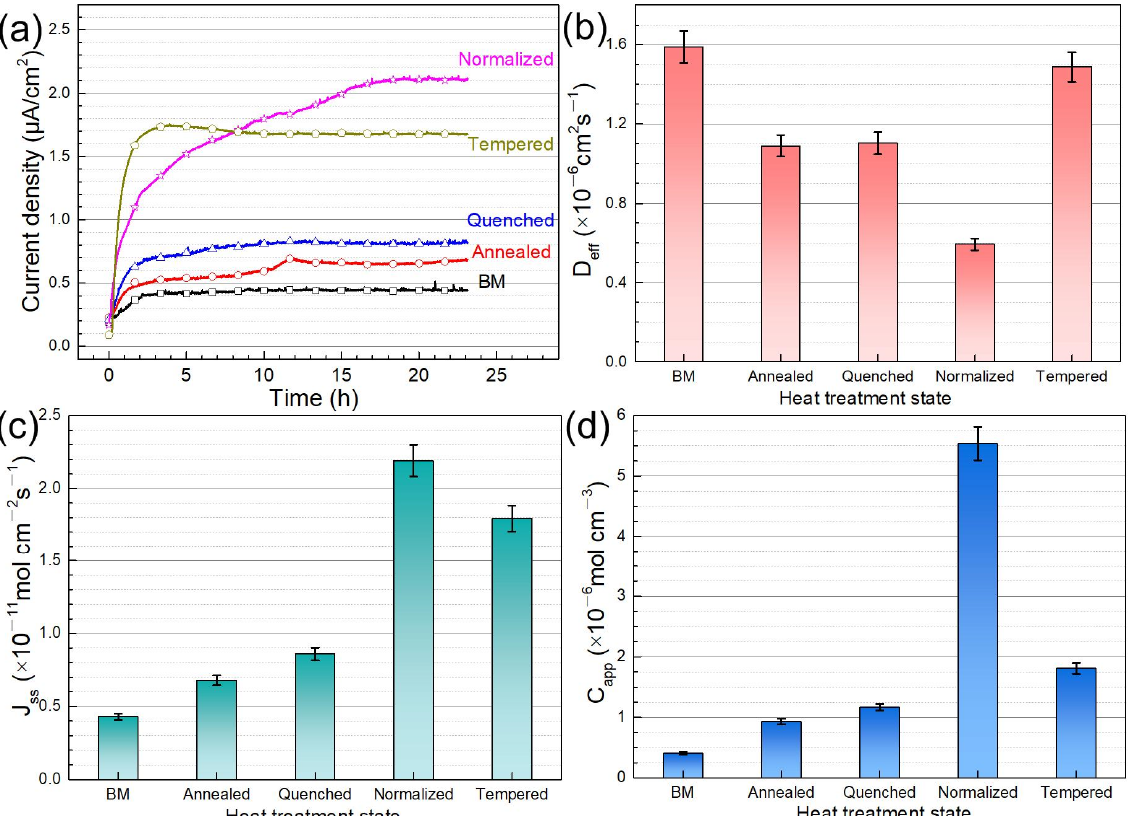
Figure 12. Hydrogen permeation curves ( a ) and the calculated parameters including D eff ( b ), J ss ( c ), and C app ( d ) of the steel with different microstructures in NaOH solution containing thiourea at − 1.25 V (vs. Ag/AgCl).